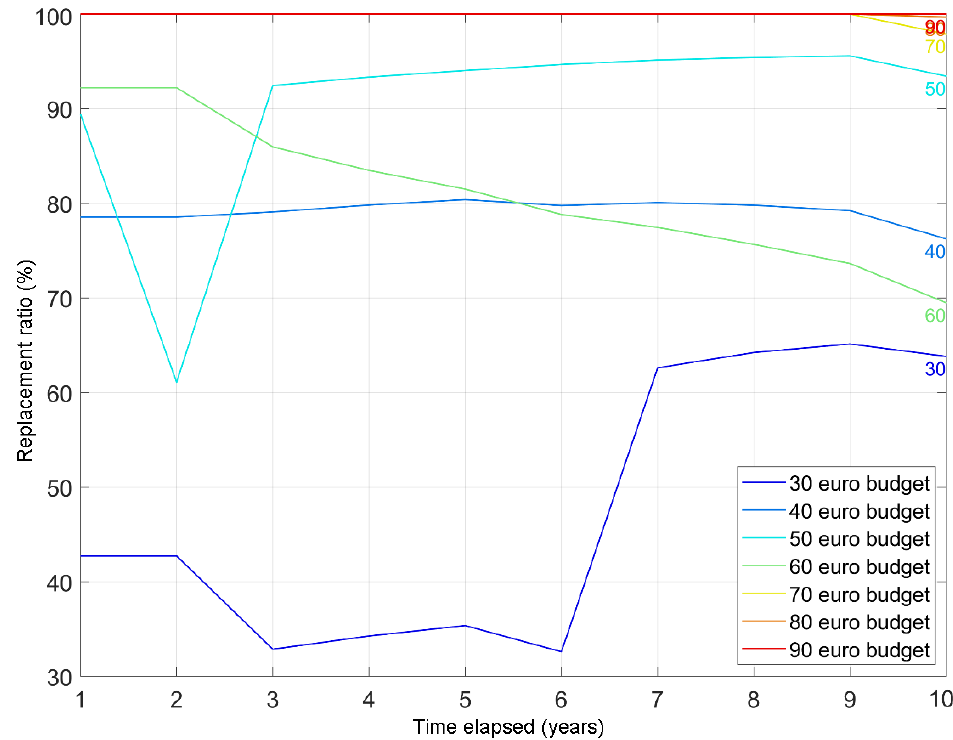
Figure 7. Replacement ratio % versus time elapsed for a washing machine’s PCB.